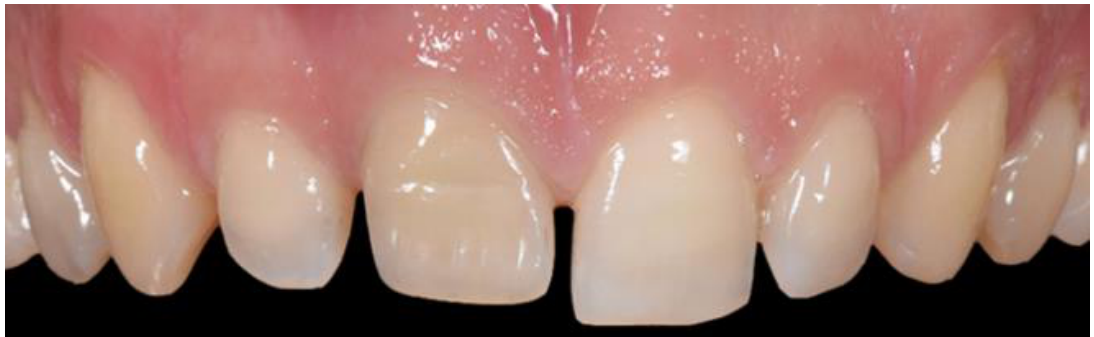
Figure 1. Pre-operative clinical conditions; thin gingival biotype and marginal apical dislocation of free gingival margin on tooth #1.1.